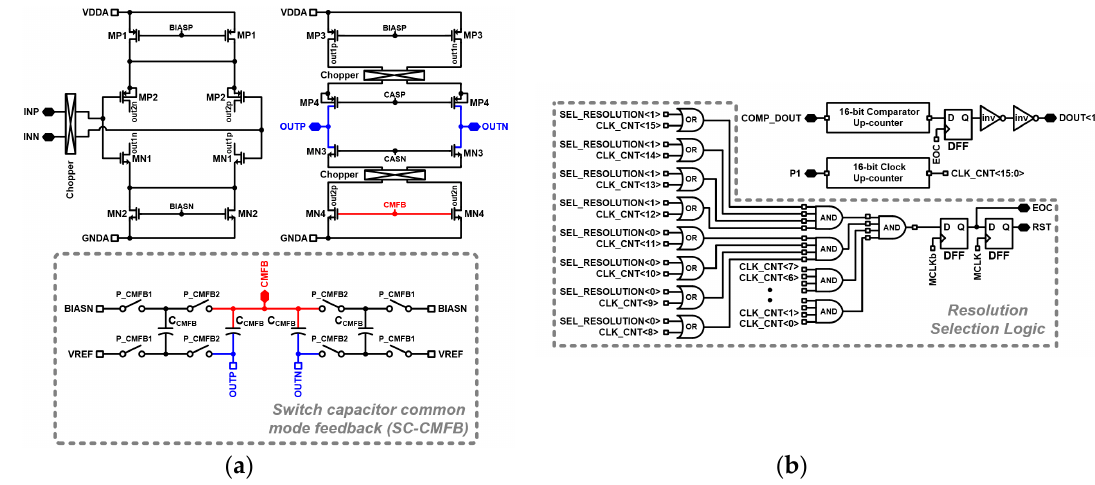
Figure 5. Schematic of fully differential chopper amplifier and accumulator. ( a ) Fully differential chopper amplifier; ( b ) Resolution selectable accumulator.